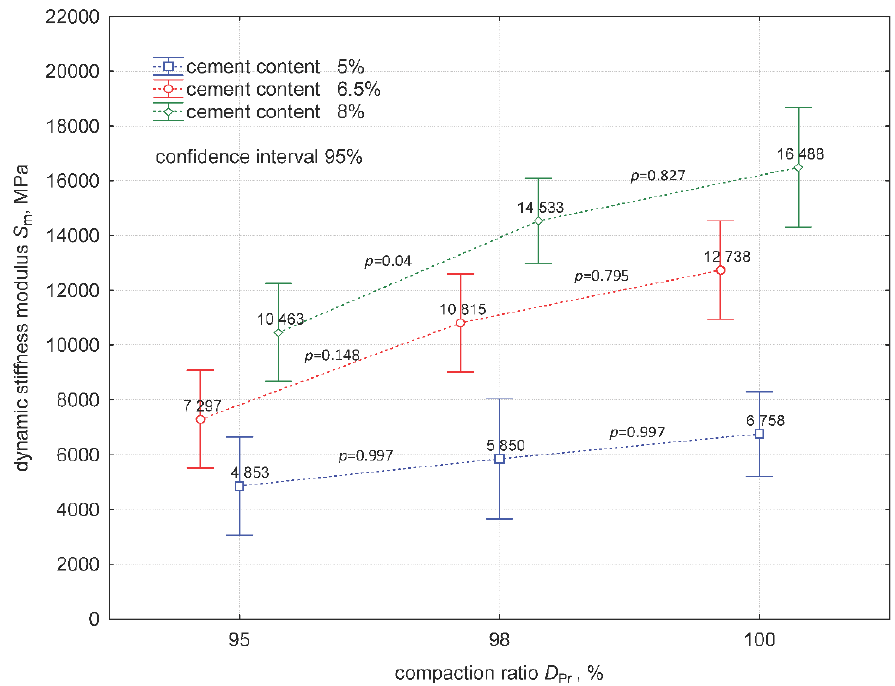
Figure 9. Diagram of variance of 𝑆 𝑚 values and significance of differences between pairs of means.